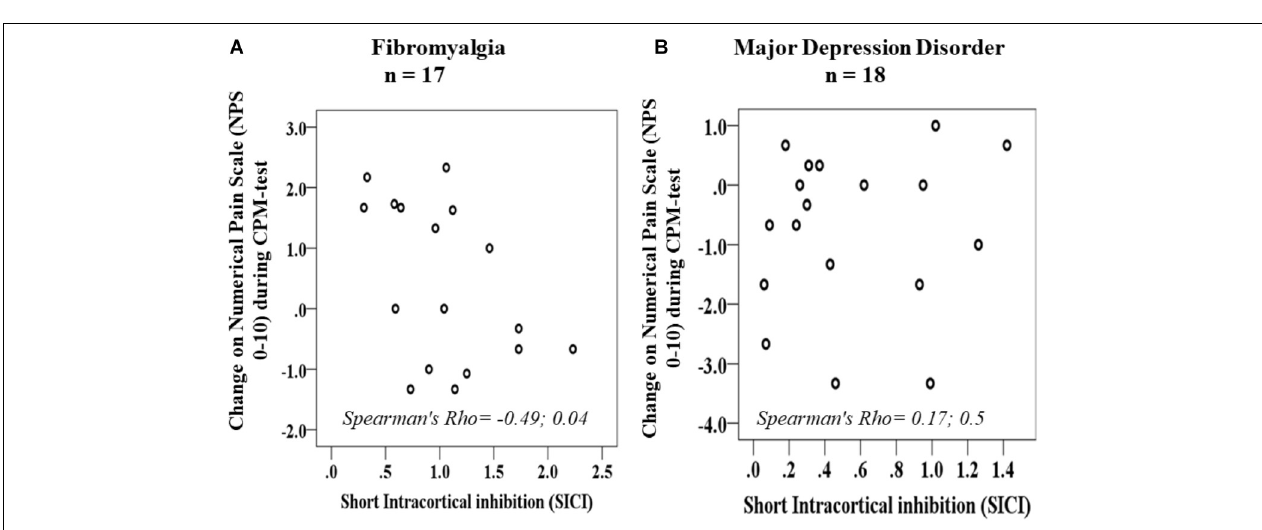
FIGURE 3 | Scatter plots of change on NPS during CPM-test and SICI according to fibromyalgia (A) and major depressive disorders (B)